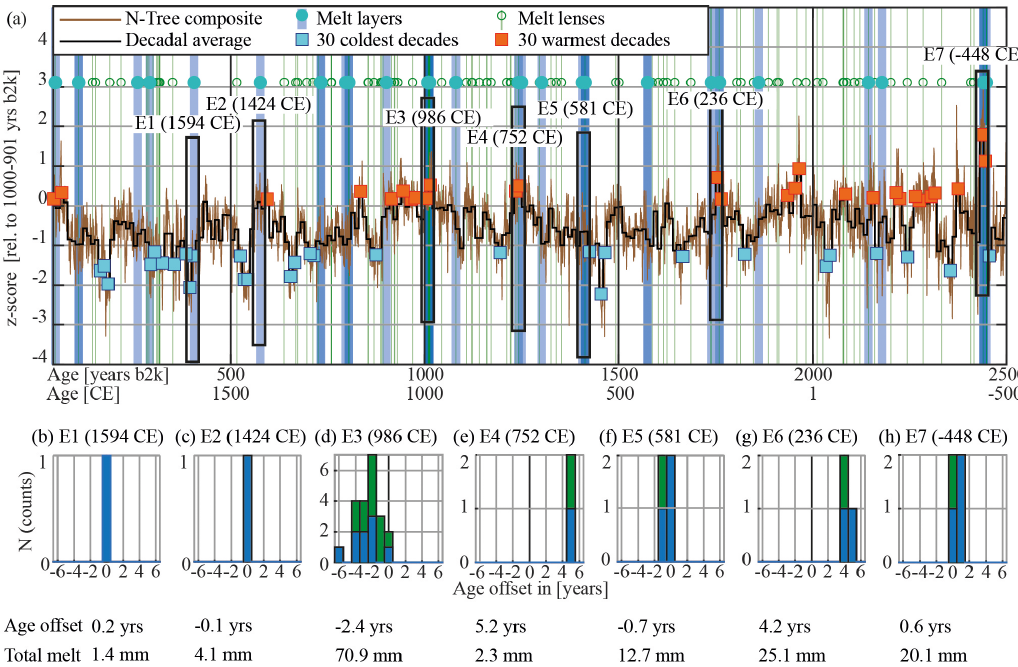
Figure 9. Tree-ring growth anomaly (Sigl et al., 2015) compared to the EastGRIP melt record from 44 to 2500 years b2k. (a) The tree-ring growth anomaly (brown) is averaged to decadal resolution (black), and the 30 warmest and 30 coldest decades are marked as orange and light blue boxes, respectively. Vertical bars highlight melt layers (blue) and lenses (green) at the corresponding ages. Seven melt events (E1 to E7) are highlighted by black boxes. (b–h) Histograms of the age offset of a melt event from the largest tree-ring growth year within ± 6 years (layers in blue, lenses in green). The exceptional 986CE event (E3) is younger than the tree ring maximum by about 2.4 years. The entire figure is based on the NS1-2011 tree ring timescale; the only exceptions are dates of events, e.g., 986CE, which are based on GICC05 for